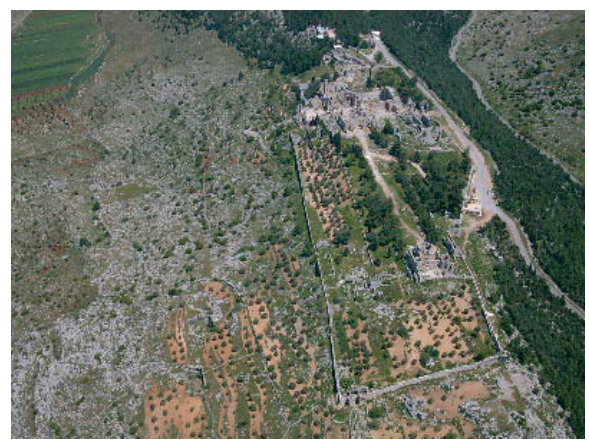
Figure1. Arian photo for Qal’at sem’an (Y. Guichord CNRS